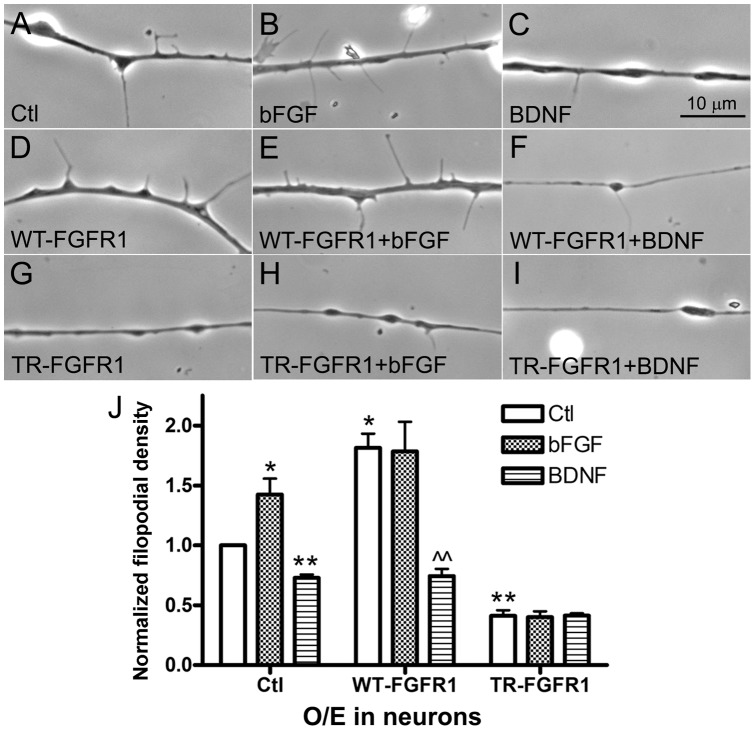
Opposite effects of bFGF and BDNF signaling on filopodial formation in spinal neurons.Spinal neurons were incubated in control medium (A) or medium containing (B) bFGF or (C) BDNF. Filopodial assembly was enhanced and suppressed by bFGF and BDNF respectively (J). Neurons expressing WT-FGFR1 or TR-FGFR1 were also maintained in control medium (D, G) or medium containing bFGF (E, H) or BDNF (F, I). WT-FGFR1 expression elevated the basal filopodial density in neurons, and this was not increased by bFGF-addition but was suppressed by BDNF-treatment (J). TR-FGFR1 expression blocked both basal and bFGF-induced formation of filopodia in neurons, and BDNF did not further reduce filopodial growth (J). The density of filopodia in control neurons (A) was used for normalizing all other filopodial density values. Mean and SEM shown; t test: *p<0.05 and **p<0.01, compared with untreated Ctl; ??p<0.01, compared to untreated WT-FGFR1-neurons.